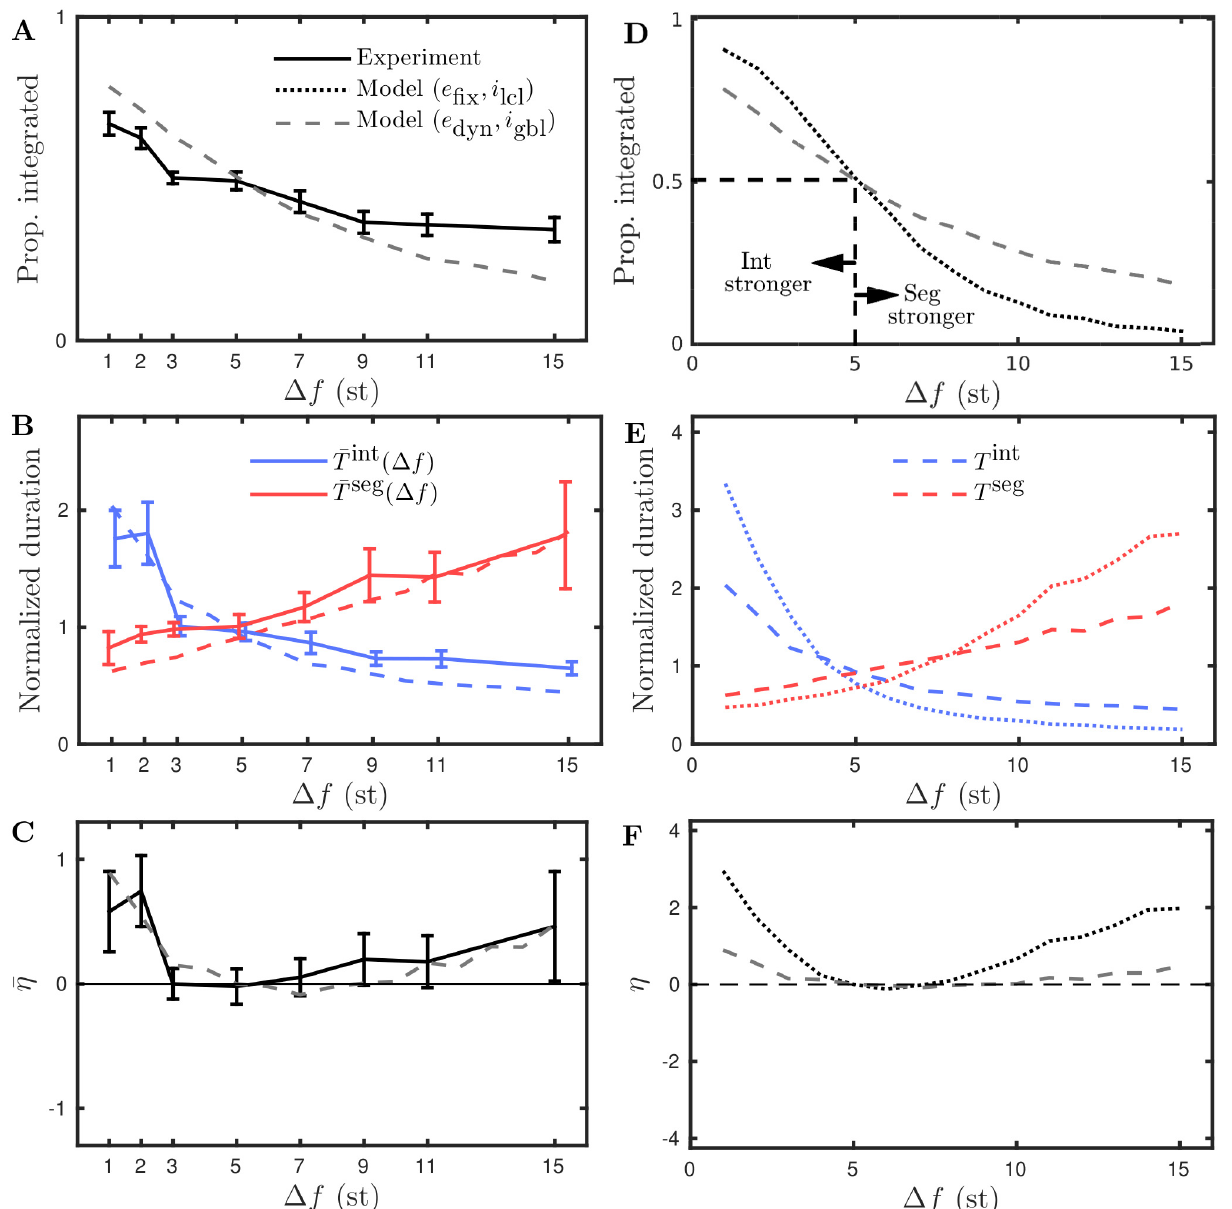
Fig 9. Parametric dependence of perceptual dominance: experiment. Comparison of experimental and computational results. A – C : Proportion integrated, durations integrated and segregated, and the measure η plotted against Δ f . Experimental data are solid curves with data points at the Δ f -values indicated on the x-axis, error bars show standard error of the mean with N = 15 subjects except at Δ f = 1 ( N = 13) and Δ f = 15 ( N = 14). Model data with dynamic recurrent excitation and global inhibition ( e dyn , i gbl ) plotted for comparison. D – F : Model data with ( e dyn , i gbl ) plotted with model data for fixed recurrent excitation and spatially localized inhibition ( e fix , i lcl ) for